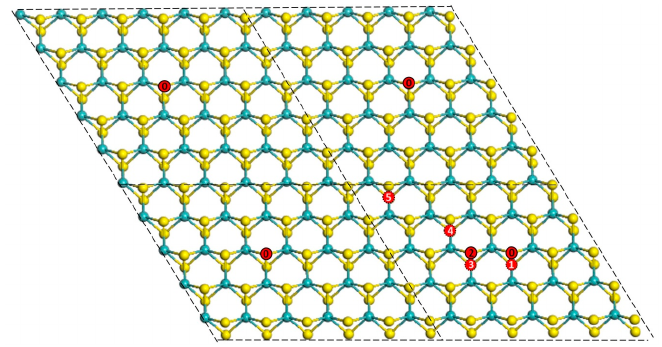
10 of 21 Figure 4. Orbitals of the highest occupied valence band (HOVB) in the Mn adsorbed-doped ZnO monolayers ( a ); electronic charge density ( b ); and electronic structures ( c ) [82]. Copyright © (2017) American Chemical Society (ACS), http://pubs.acs.org/doi/full/10.1021/acsomega.7b00093. Reproduced with permission from ACS. Further permission related to the excerpted material should be directed to the ACS. Dimensionality reduction, by reducing the spatial variables, introduces spatial symmetry effects into the doped ILC systems. As another basic concept, space symmetry is found to substantially influence the final magnetism. In the dually doped MoS 2 complexes, a general trend illustrates that spatial symmetry leads the broken symmetries in magnetism. This is seen in the dually doped system when two Cr impurities are placed mirror symmetric to each other through the MoS 2 monolayer (noted as TM0 and TM1 positions in Figure 5). The high symmetric configuration creates AFM in the double-sided doped system. Compared with the magnetic interactions between ions, such a